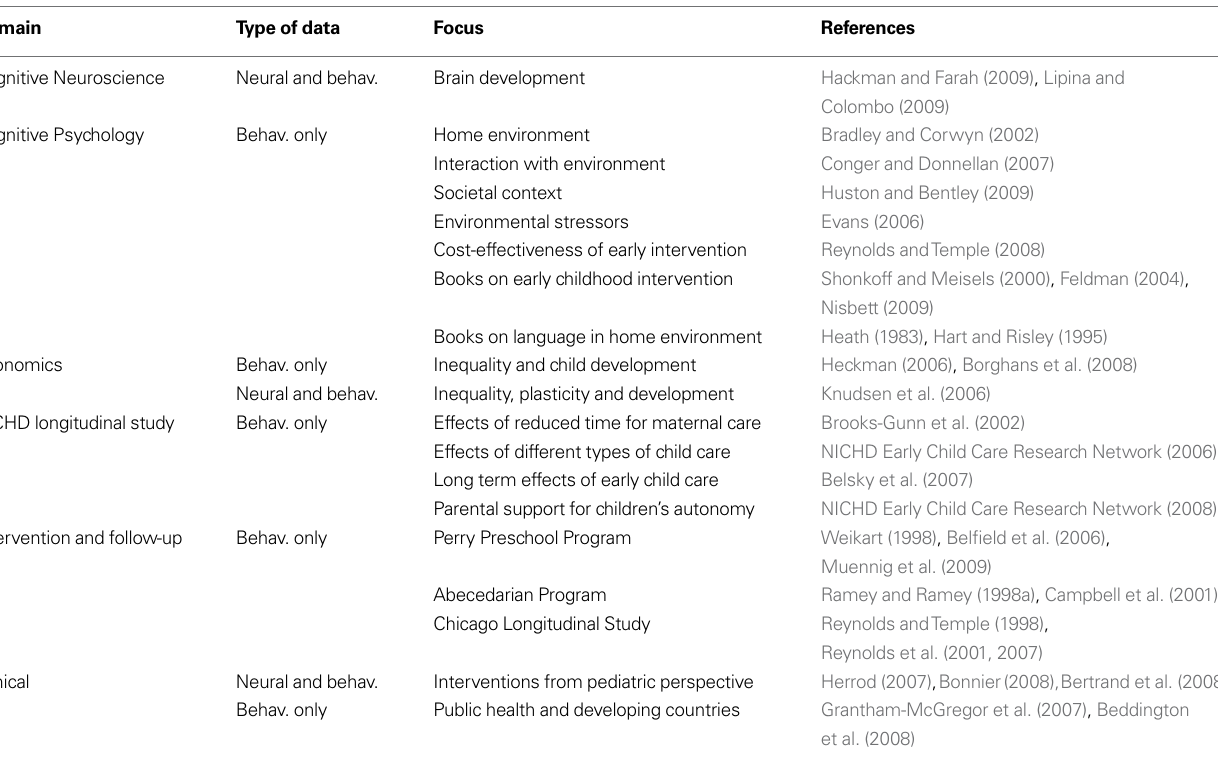
Table 1 | Summary of recent reviews on the relations between SES and cognitive development, from diverse fi elds.